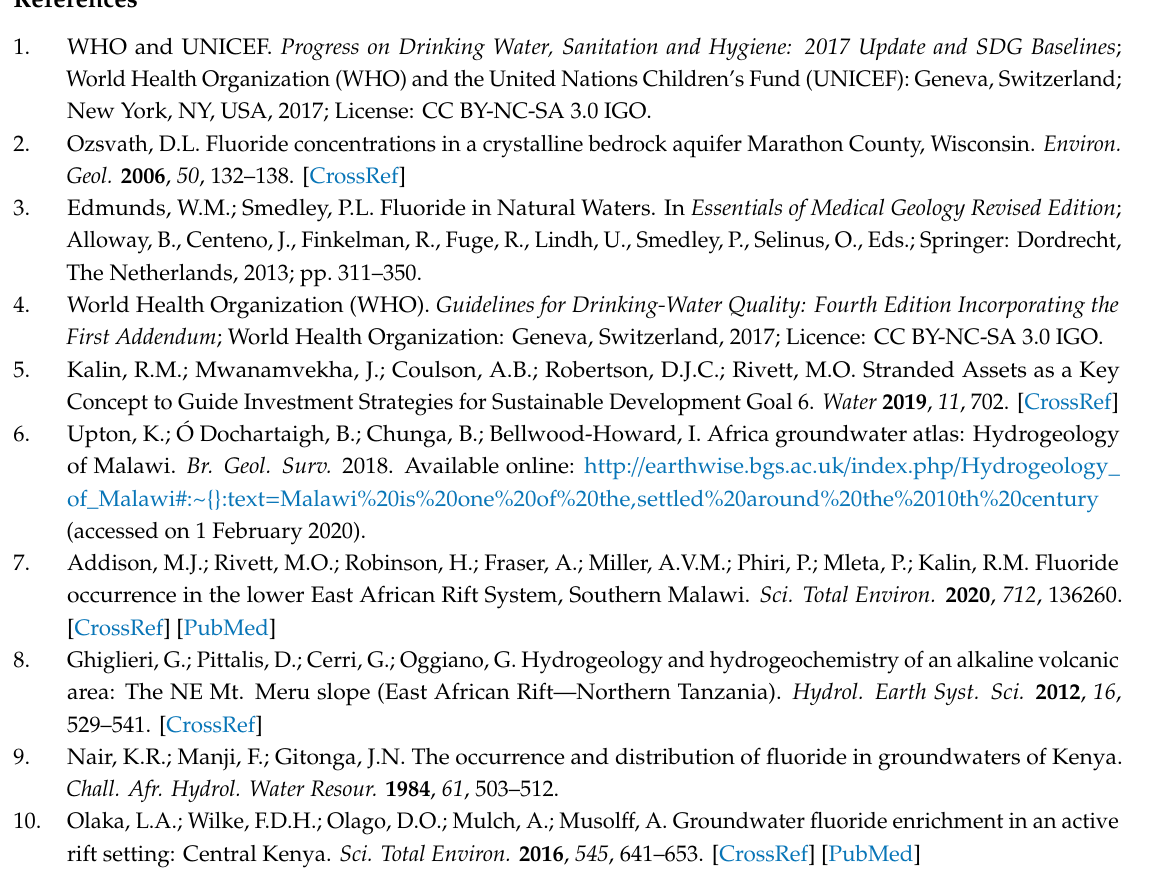
s1, Table S1: summary statistics for fluoride data in the study area, Table S2: geochemical data from TA Mazengera